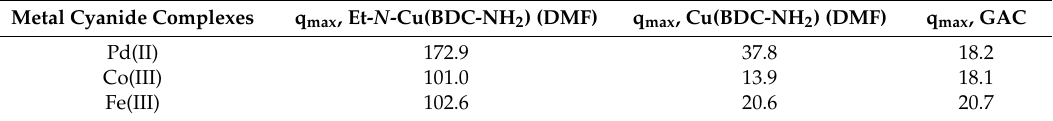
Table 2. The maximum adsorption capacities for the metal cyanide